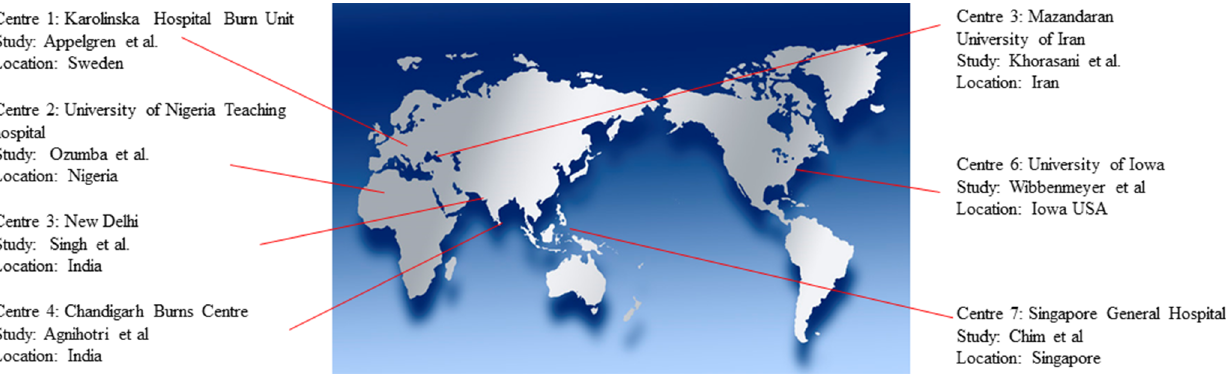
Figure 3. Geographic distribution of the centres from which studies were critically appraised. The study design and sample size are provided in figure 2.